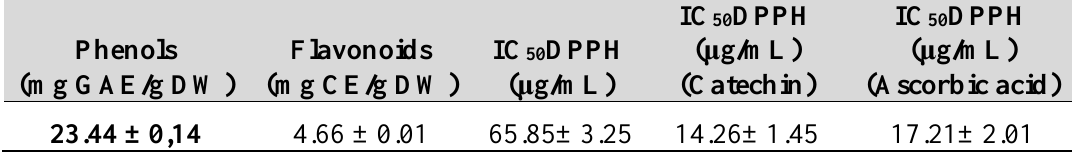
Table 1. The total phenolic and flavonoids contents and antioxidant activity of hydromethanolic extract of Adiantum capillus-veneris.